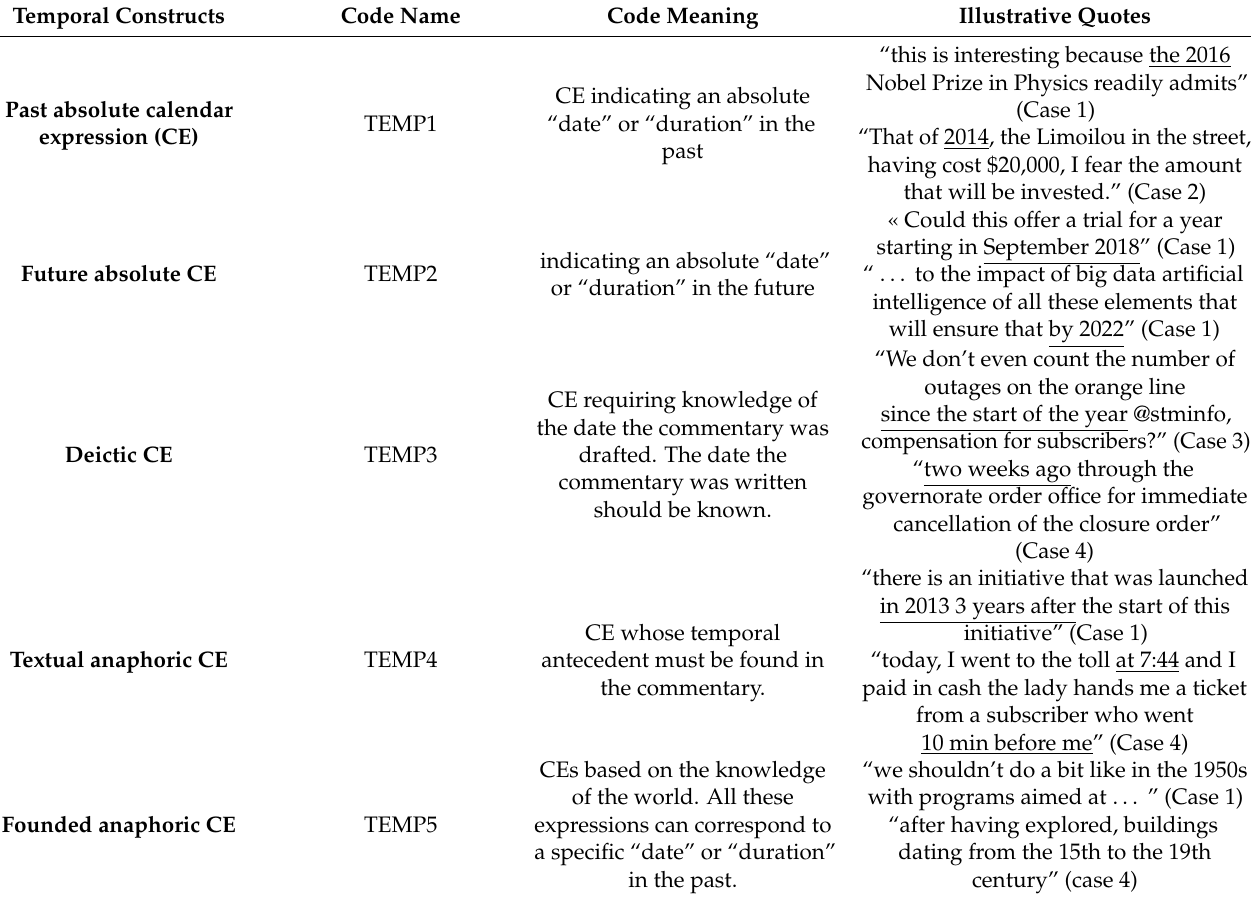
Table A6. Temporal patterns in both online and offline SP data.